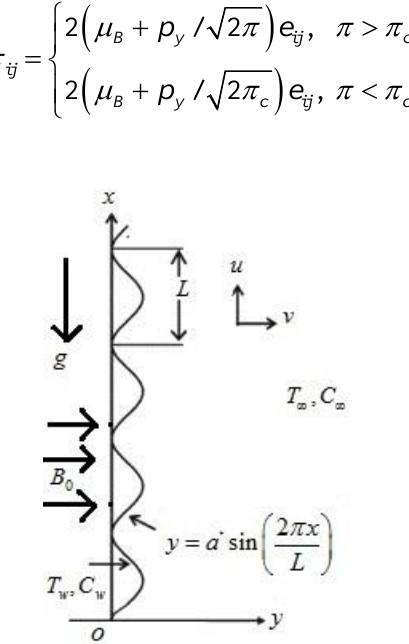
Fig. 1. Physical model of the